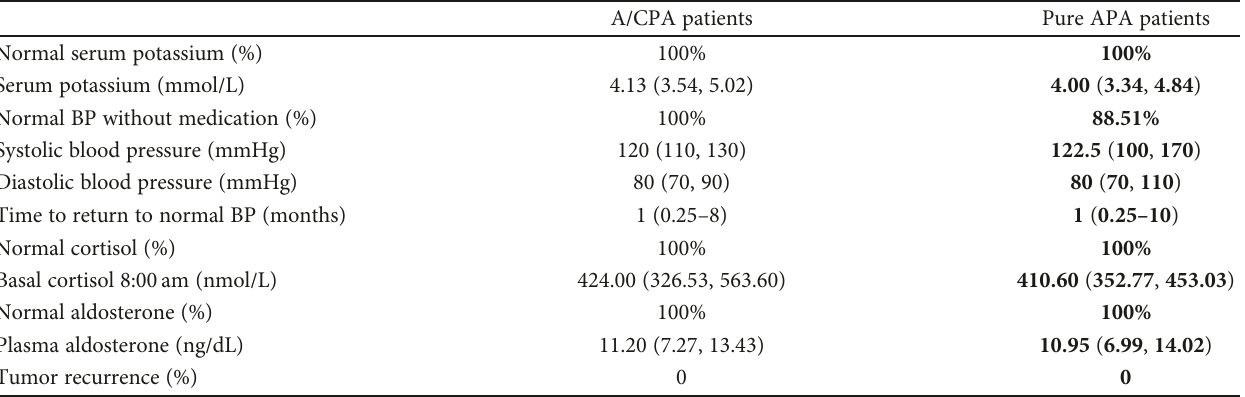
Table 3: Postsurgical clinical and hormone parameters of A/CPA and pure APA